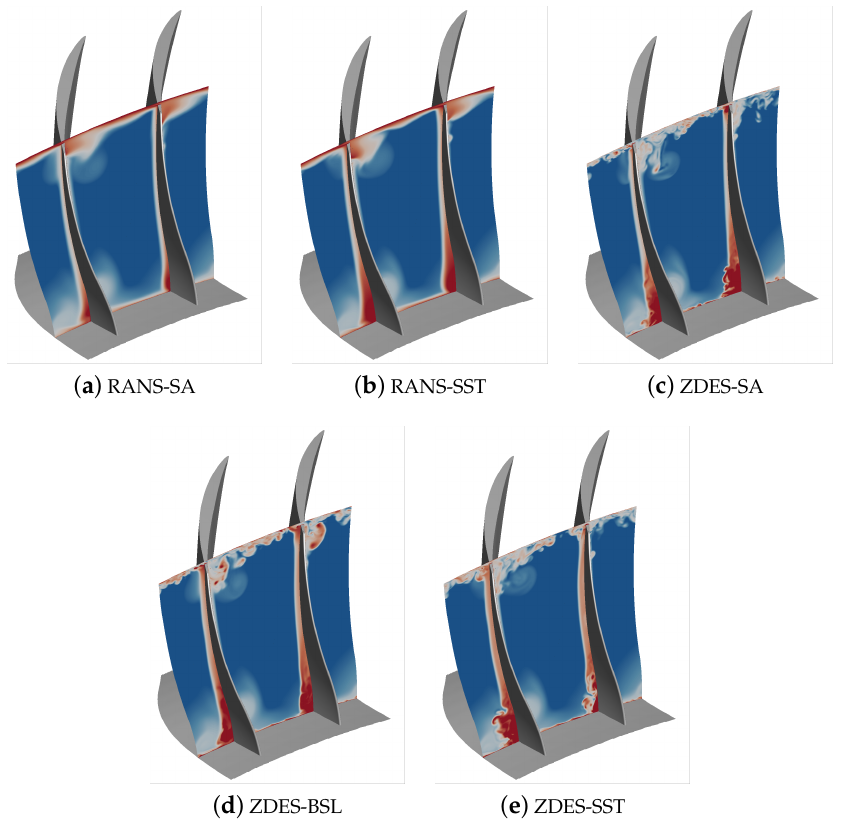
Figure 15. Entropy variation field in plane located at 91% x/c at t = 3 T